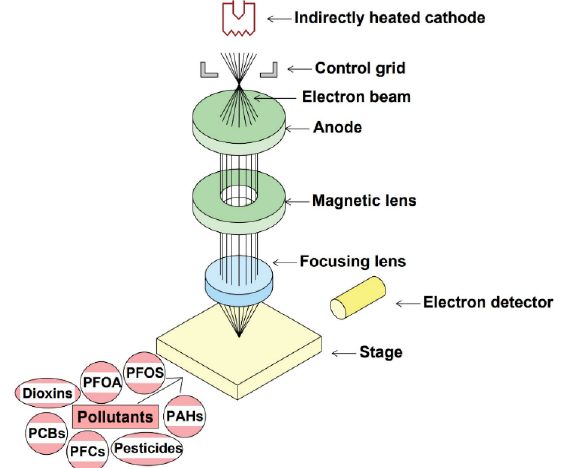
Figure 1. Schematic illustration of electron beam and its applications in treating different organic pollutants.